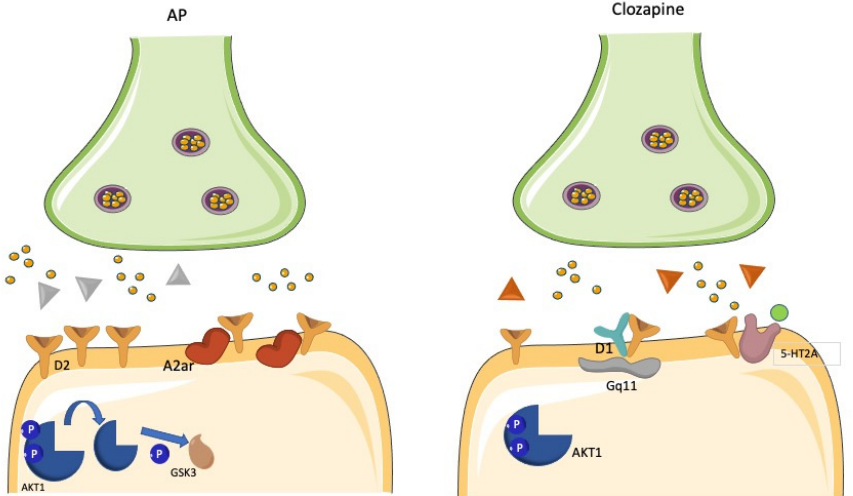
Figure 8. Clozapine is considered the gold-standard intervention in treatment resistant patients, but the unique molecular mechanisms of its superior efficacy in comparison to conventional an- tipsychotics are still undetermined. The figure depicts some putative mechanisms: D2R/5HT1AR heterodimer levels increase; uncoupling of the D1/D2R heteromer complex in the high-affinity state; lack of time and concentration-dependent increase in surface D2R expression; selective targeting of a unique Gq-mediated second messenger pathway; increased AKT1 and GSK-3 phosphorylation; prevention of the increase in A2AR/D2R heteromer levels, whose formation may contrast the effects of independent A2AR activation in attenuating D2R-mediated